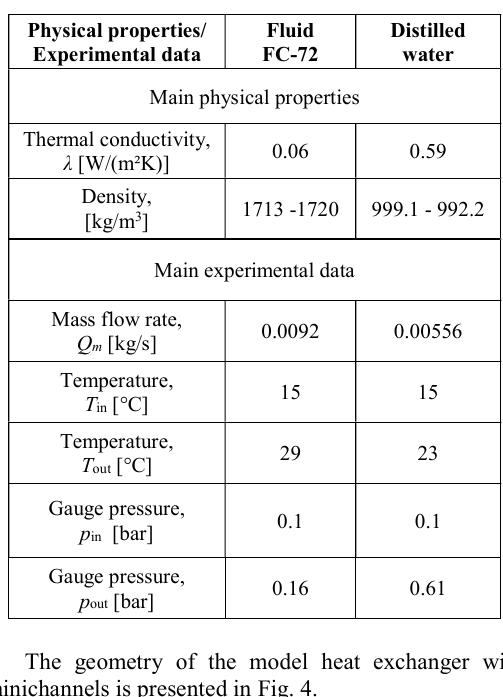
Table 2. Main fluid properties and experimental data.